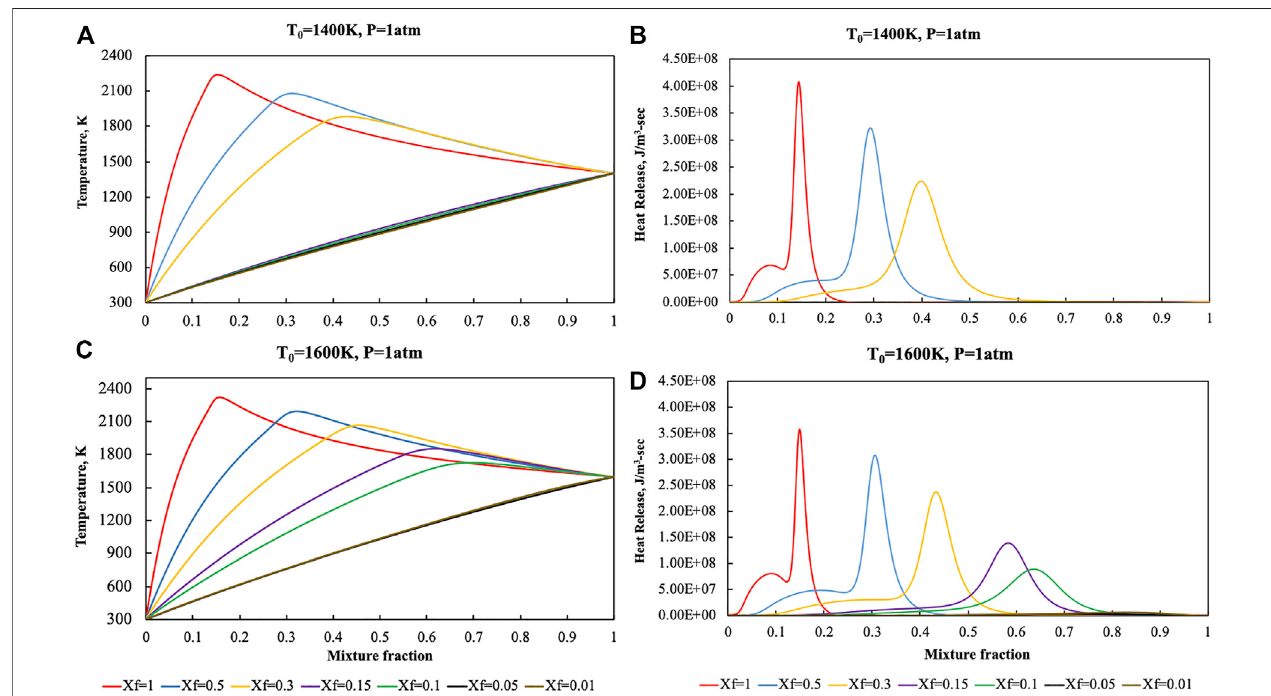
FIGURE3| Temperature and heat release pro fi les for pure ammonia parametric in X f in the HFDF con fi guration for T 0 (cid:1) 1,400 K (A, B) and T 0 (cid:1) 1,600 K (C, D) , K 0 (cid:1) 50 s − 1 , P (cid:1) 1